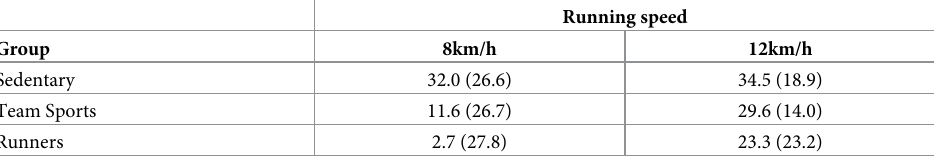
Table 1. Percentage of underestimation of visual speed relative to running speed. Estimations were computed using the equation: ln(perceived visual speed / actual treadmill speed) � 100 . Values are means (SD).